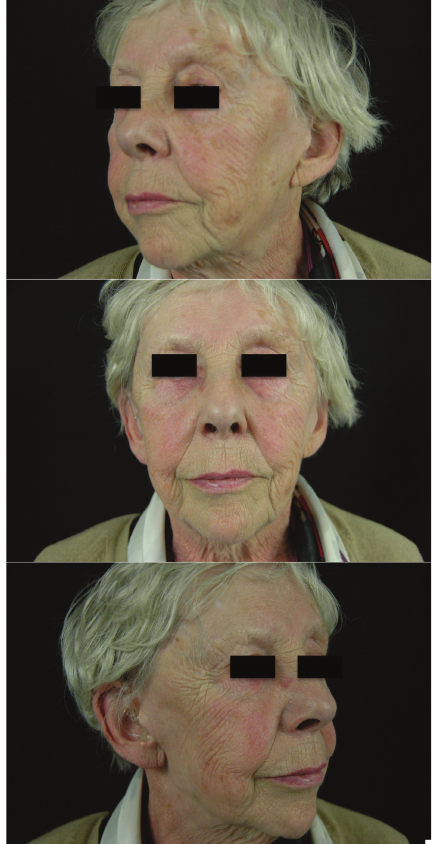
Figure 2: 77 year-old woman 15 months after a right parotidectomy and an immediate autologous fat graft (18mL of fat for 32 gr of parotid parenchyma resected). A Minor’s starch-iodine test was performed 6 and 14 months after the procedure and remained